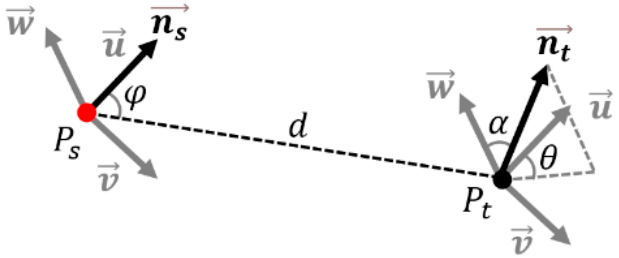
3.3. Template Matching of Point Clouds